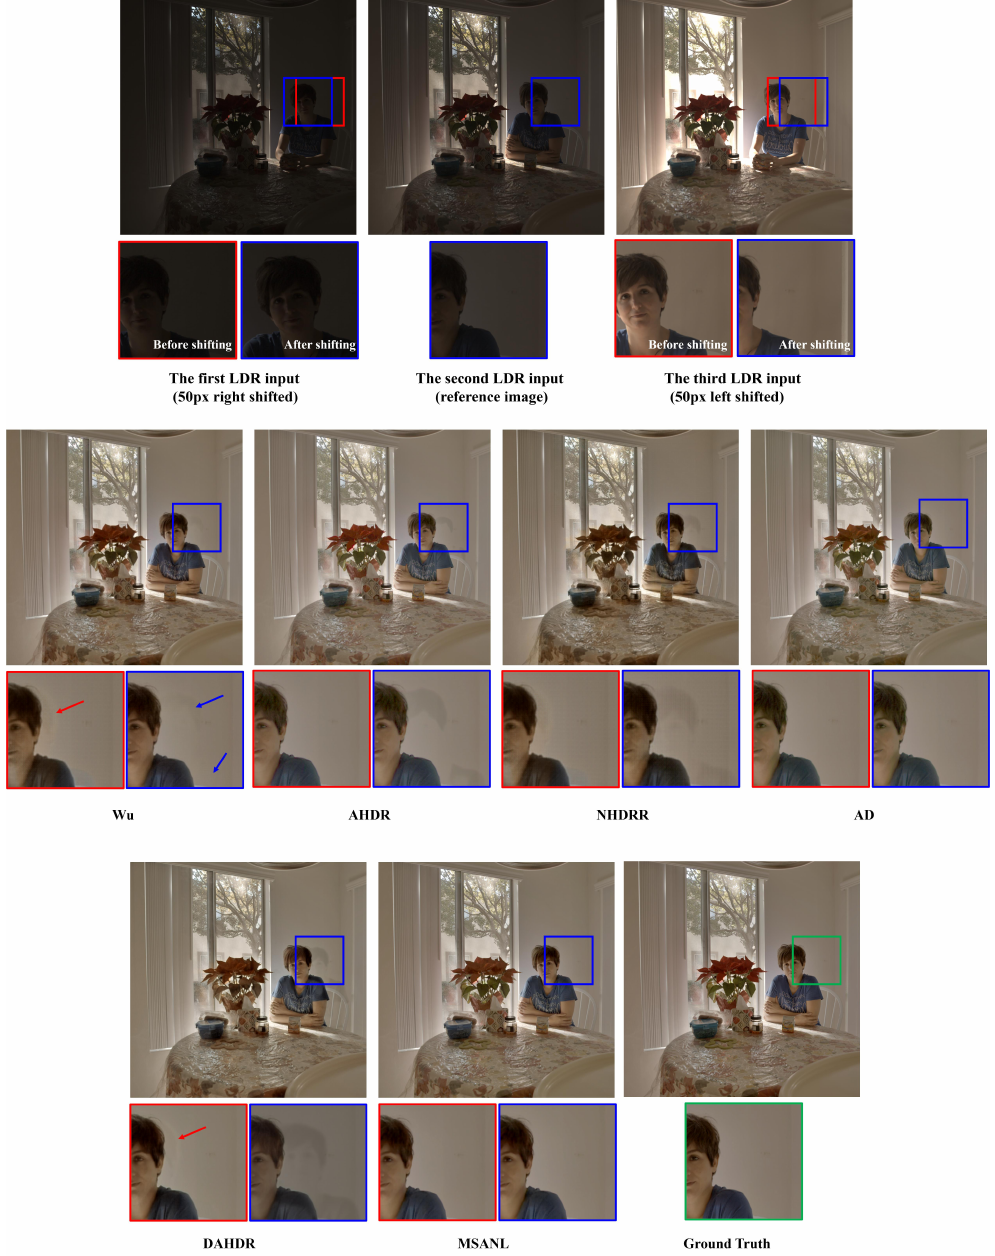
Figure 10. Visual comparison of degradation of HDR restoration for global motion (i.e., when applied translation). From left, Wu [28], AHDR [26], NHDRR [30], AD [27], DAHDR [39], and Proposed